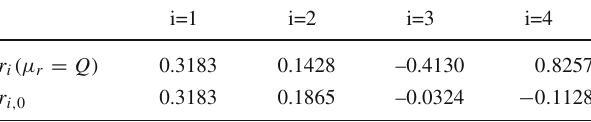
Table1 Theknowncoefficientsfor R n ( Q ) .Thecoefficientsofconven- tional scale setting, r i (μ r ) , are for μ r = Q . The conformal coefficients, r